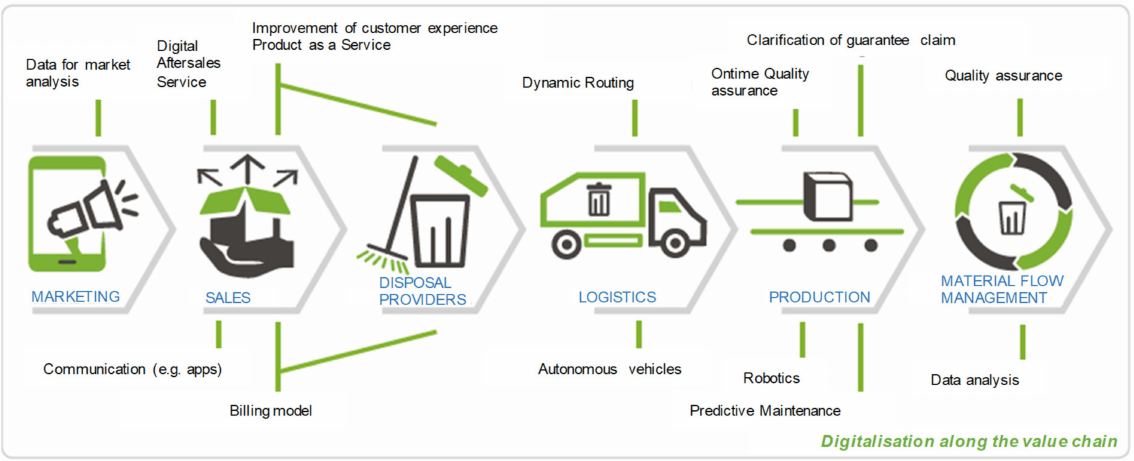
Figure 4. Digitalization along the value chain